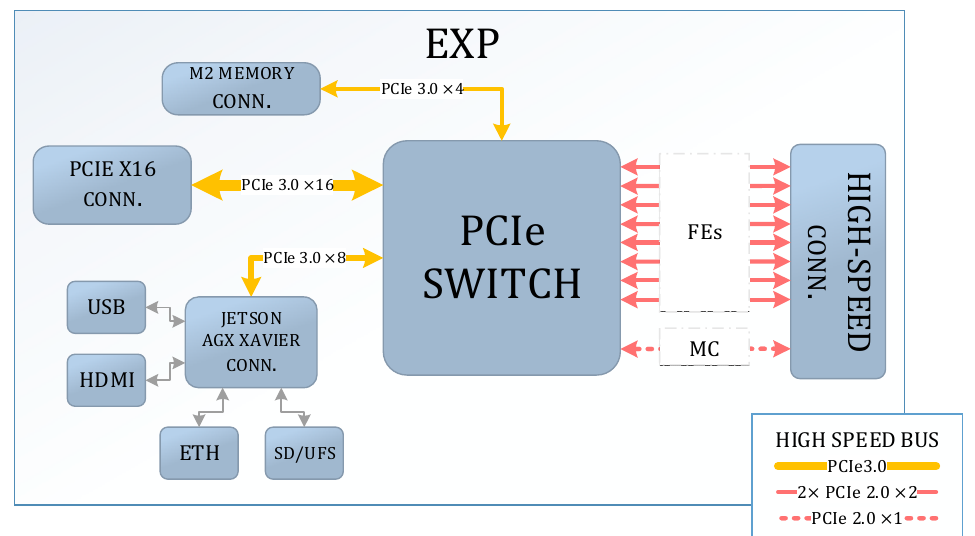
Figure 3. Peripheral Component Interconnect Express (PCIe) connection diagram of the expansion board. The PCIe2.0 and PCIE3.0 buses are shown in red and yellow lines, respectively. The diagram of the PCIe connections is highlighted in Figure 3: